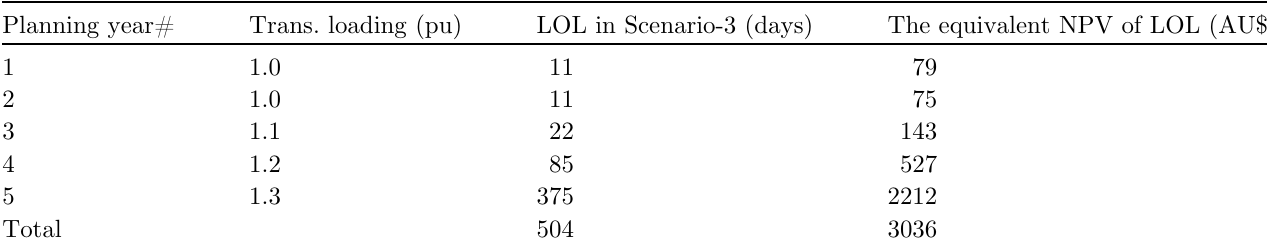
Table 4. LOL of the considered distribution transformer and the corresponding equivalent cost in Scenario-3 at all years of